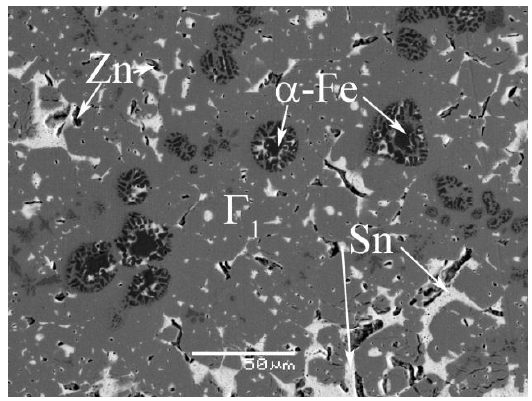
Figure 8. The microstructure of Alloy A11.